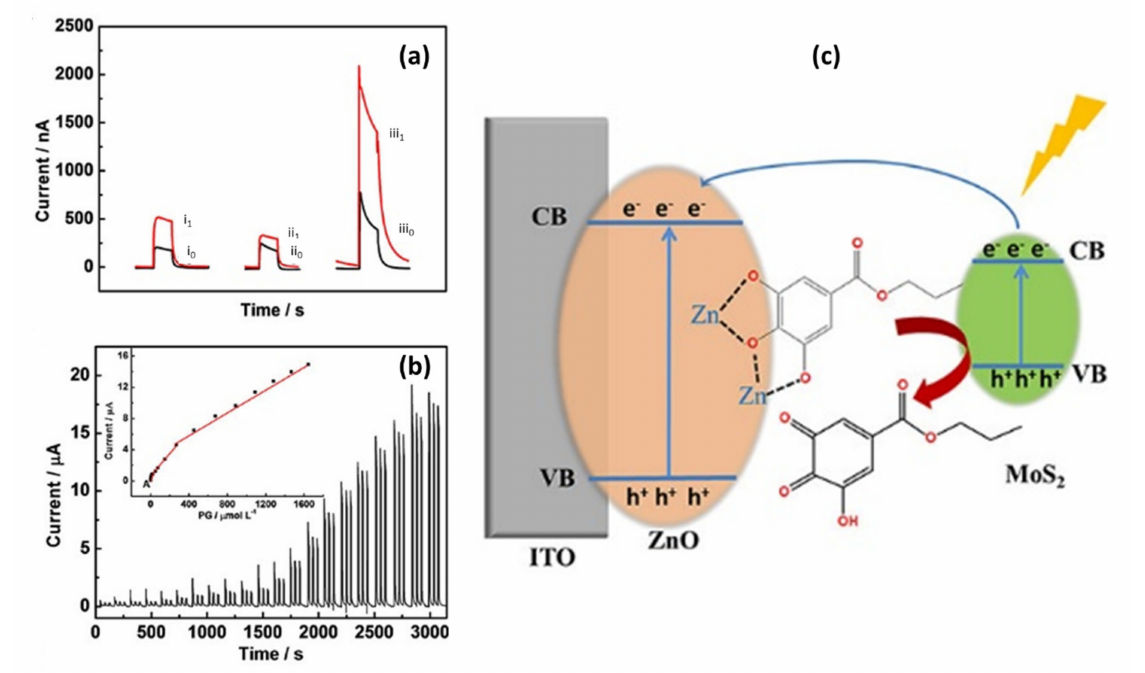
Figure 13. ( a ) Photocurrent responses of ZnO (curves i 0 and i 1 ), MoS 2 (curves ii 0 and ii 1 ), and MoS 2 -ZnO (curves iii 0 and iii 1 )-modified ITO electrodes in the absence of (curves i 0 , ii 0 , and iii 0 ) and presence of (curves i 1 , ii 1 , and iii 1 ) 12.43 µ mol L − 1 PG. ( b ) Photocurrent responses of MoS 2 -ZnO- modified ITO electrodes upon different concentrations of PG. The inset is the corresponding linear calibration curve. ( c ) Proposed mechanism of the MoS 2 -ZnO-based PEC sensor for the detection of PG [232]. Figures reproduced with permission from Ref. [232], copyright © 2019, American Chemical